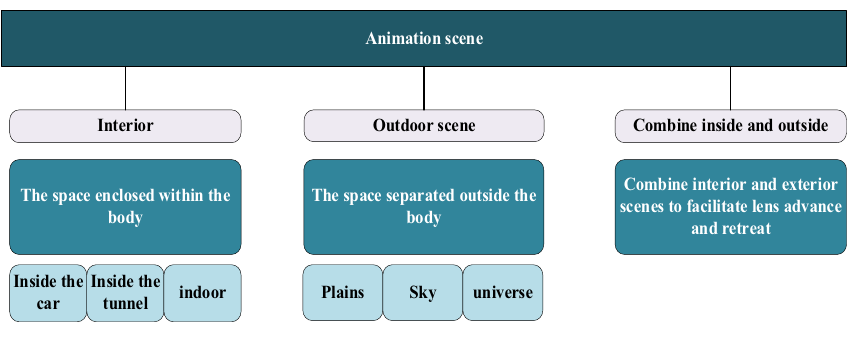
universeAnimation scene